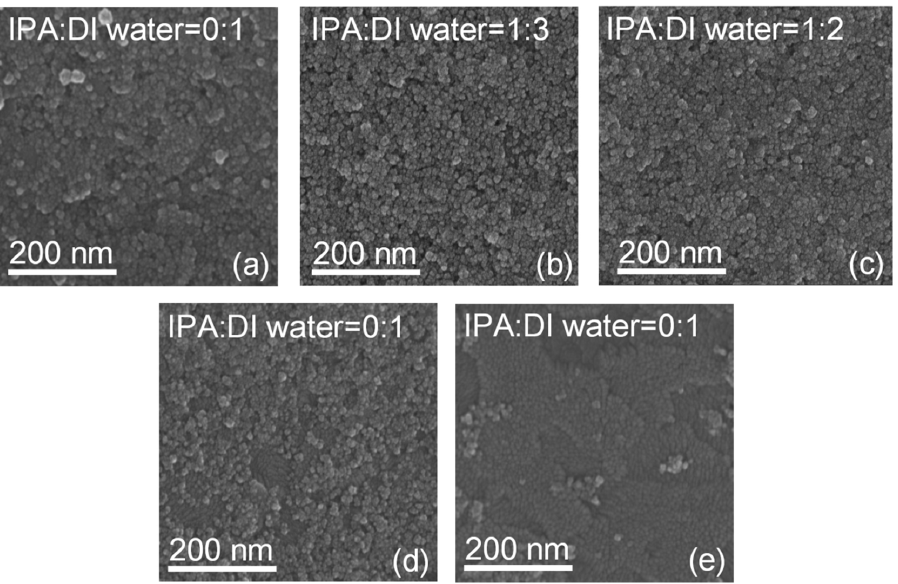
Figure 9. SEM images of NiO x films in different volume ratios of IPA:DI water in NiO x inks: ( a ) 0:1; ( b ) 1:3; ( c ) 1:2; ( d ) 1:1 and ( e ) 2:1. The NiO x films are by three times spin-coating and after 150 °C annealing.